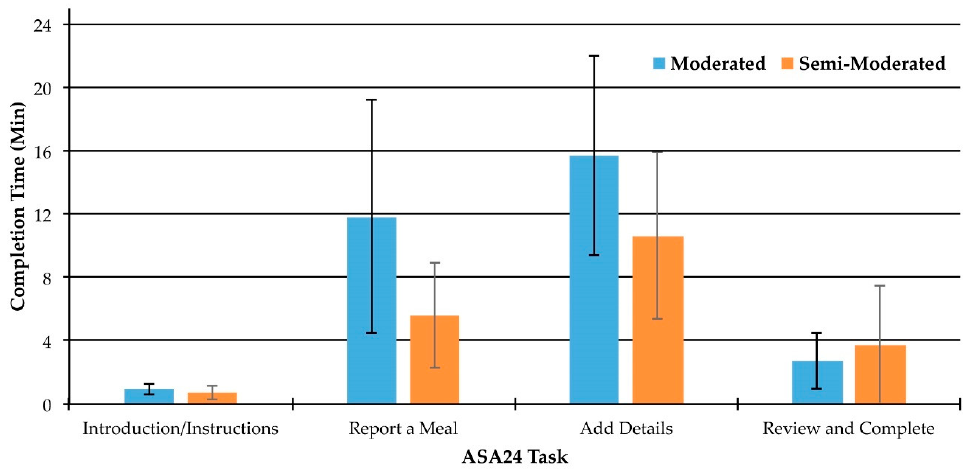
Figure 3 . Average task completion times for each task in the moderated ( n = 10) and semi-moderated ( n = 11) groups. Error bars represent one standard deviation above and below the mean.